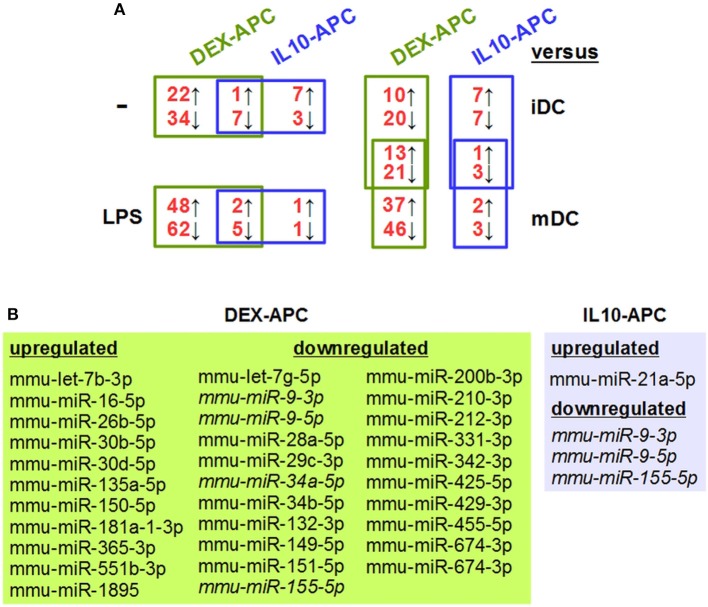
Differentially tolerized APCs at either state of activation largely differ from BMDCs in their miRNA expression signature, but show some overlap. In parallel settings, BMDCs and tolerogenic APC populations (DEX-APC, IL10-APC) were differentiated from the same bone marrow progenitors in the presence of GM-CSF, and the miRNA expression profiles of all APC populations at unstimulated state and after stimulation with LPS were assessed by array analysis in 2 independent experiments. (A) The numbers of miRNAs differentially expressed in tolerogenic APCs (DEX-APC, IL10-APC) as compared with BMDCs (iDC, mDC) are indicated (see Tables 1, 3, Tables S1, S2, S7, S8). miRNAs convergingly regulated in differentially tolerized APCs at unstimulated (see Table 1) and at stimulated state (see Table 3) as compared with the according control DC population (iDCs, mDCs) are listed in the assigned tables. (B) miRNAs convergingly regulated in differentially tolerized APCs as compared with the corresponding control DC population (iDCs, mDCs) at both states of stimulation. miRNAs commonly regulated by both APC populations at both states of stimulation are given in italics.